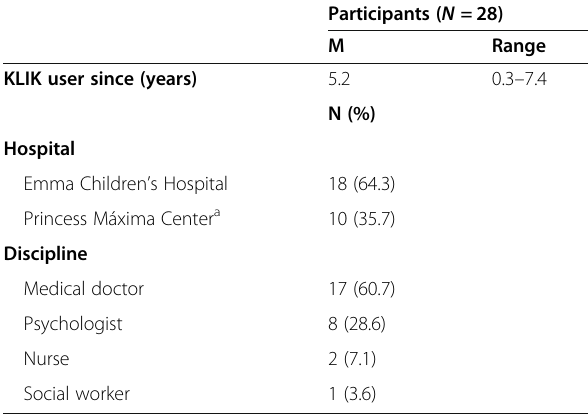
Table 1 Characteristics of participating clinicians in six focus